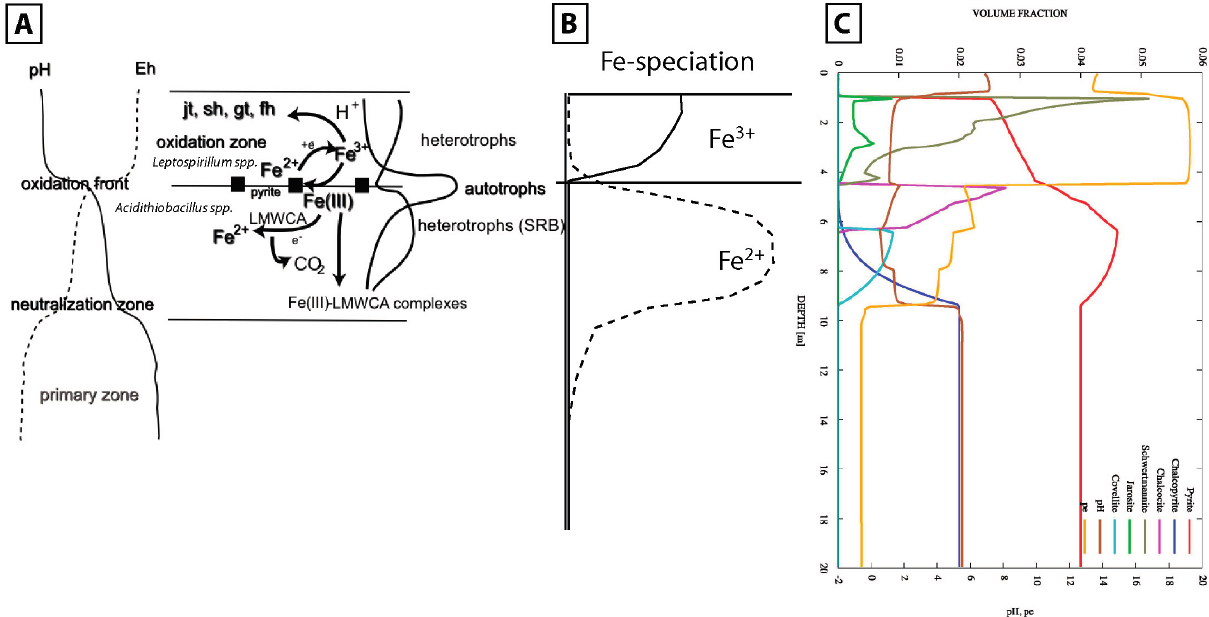
Figure 4. ( A ) Schematic model of biogeochemical iron cycling at the sulphide oxidation front (modified after Dold et al. [55]). ( B ) Schematic iron speciation as a function of the tailings depth (modified after Dold et al. [55]). And ( C ) volume fraction of the different primary and secondary sulphide and ferric iron oxide minerals as a function of tailings depth obtained by reactive transport modelling by Peter Lichtner with the code FLOTRAN [59] for 50 years of oxidation based on pore water composition in the Piuquenes tailings impoundment (with permission). The mineral distribution modelled is confirmed by the detected mineralogy in this tailings profile